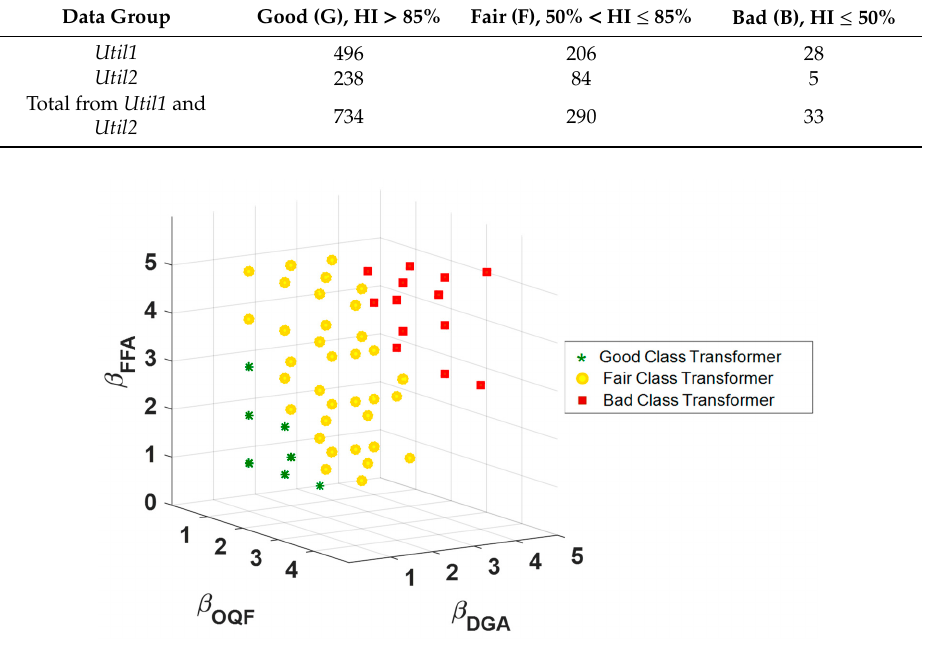
β β DGA , OQA , and FFA